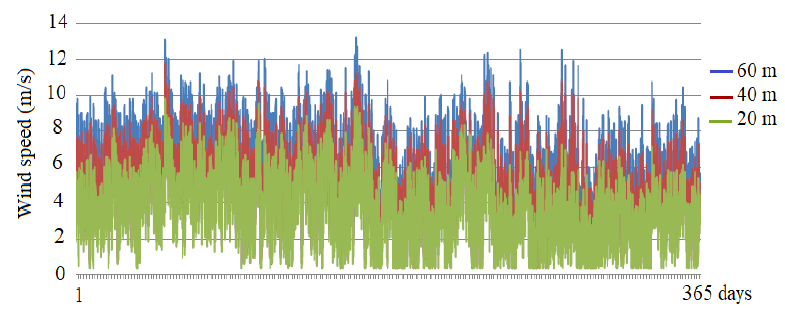
( b ) Figure 2. ( a ) Proposed site for Namaacha wind farm. Courtesy of Google Earth, land for wind farm allocation (25°58 ′ 19 ′′ S, 32°01 ′ 56 ′′ E, elevation 497M); ( b ) Overview of the wind farm’s landscape. Courtesy of FUNAE [32]. Three different wind farm layouts that differ in terms of distance between turbines,